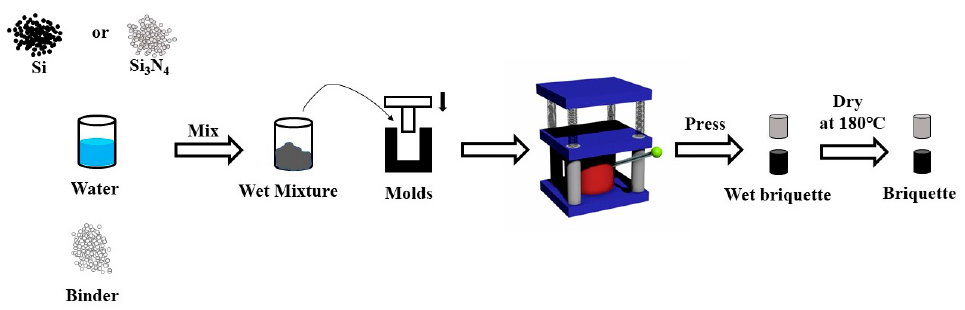
Figure 1. Schematic of the process for making cold-bonded briquettes.